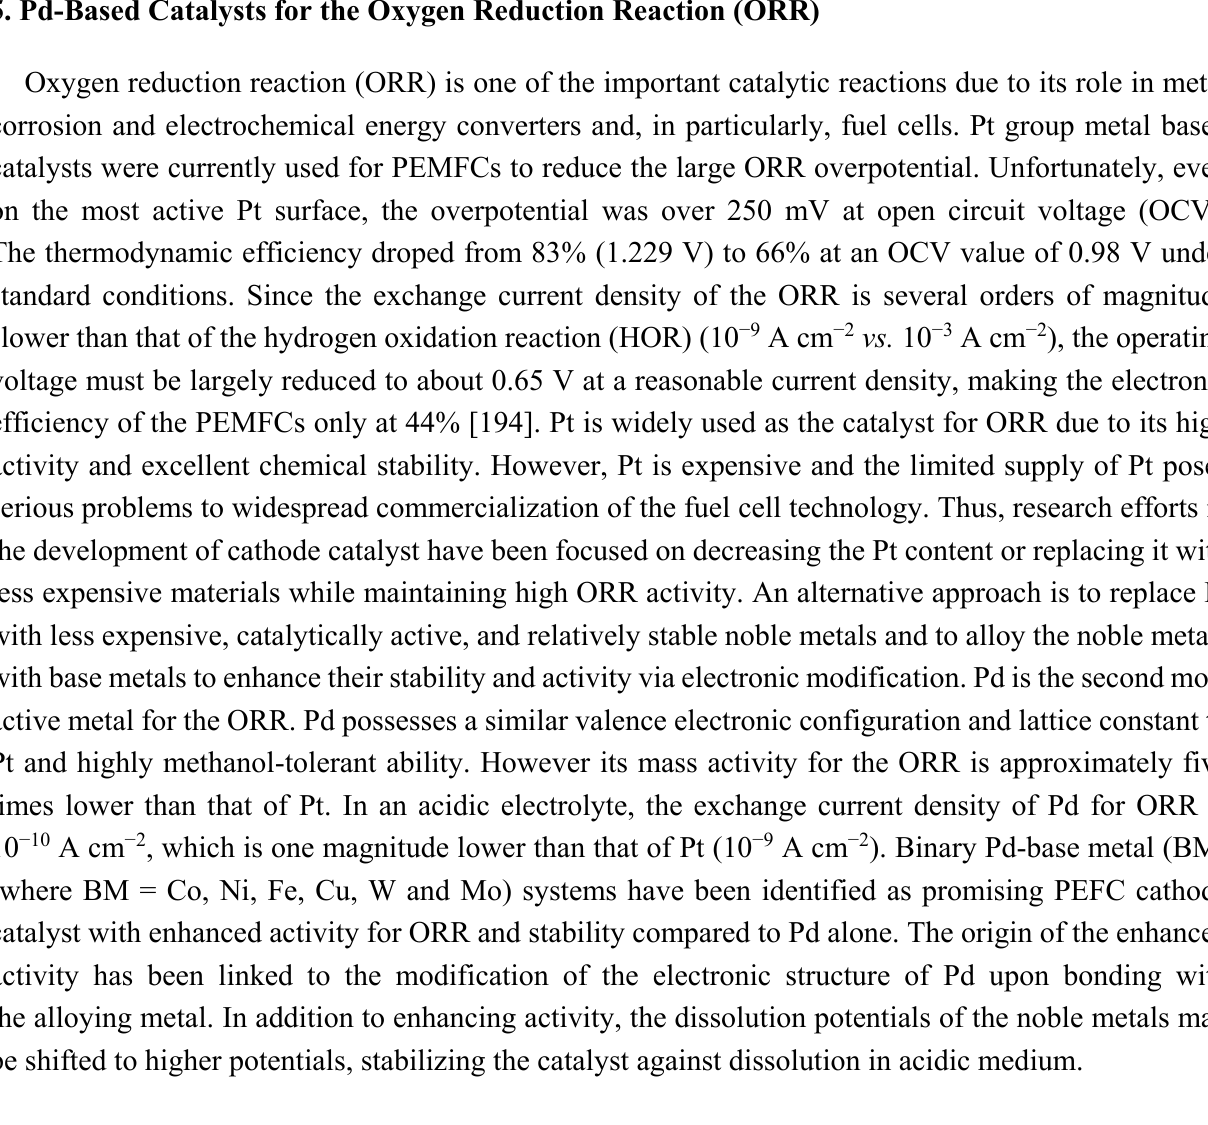
Figure 8. Peak powder density of single fuel cell performance of the Pd catalysts in anion-exchange membrane direct ethanol fuel cells